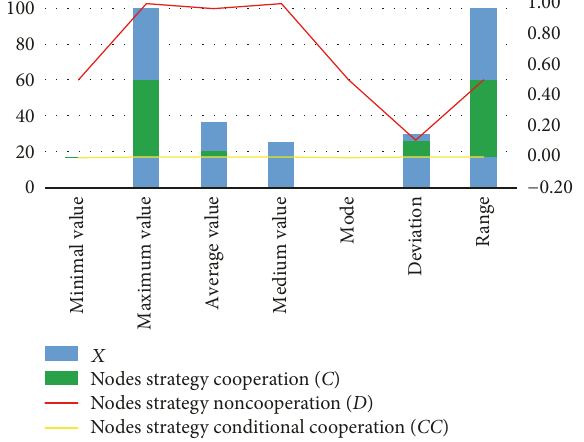
Figure 4: The state of population when 𝑋 = (0, 100, 36.64, 25.43, 0,